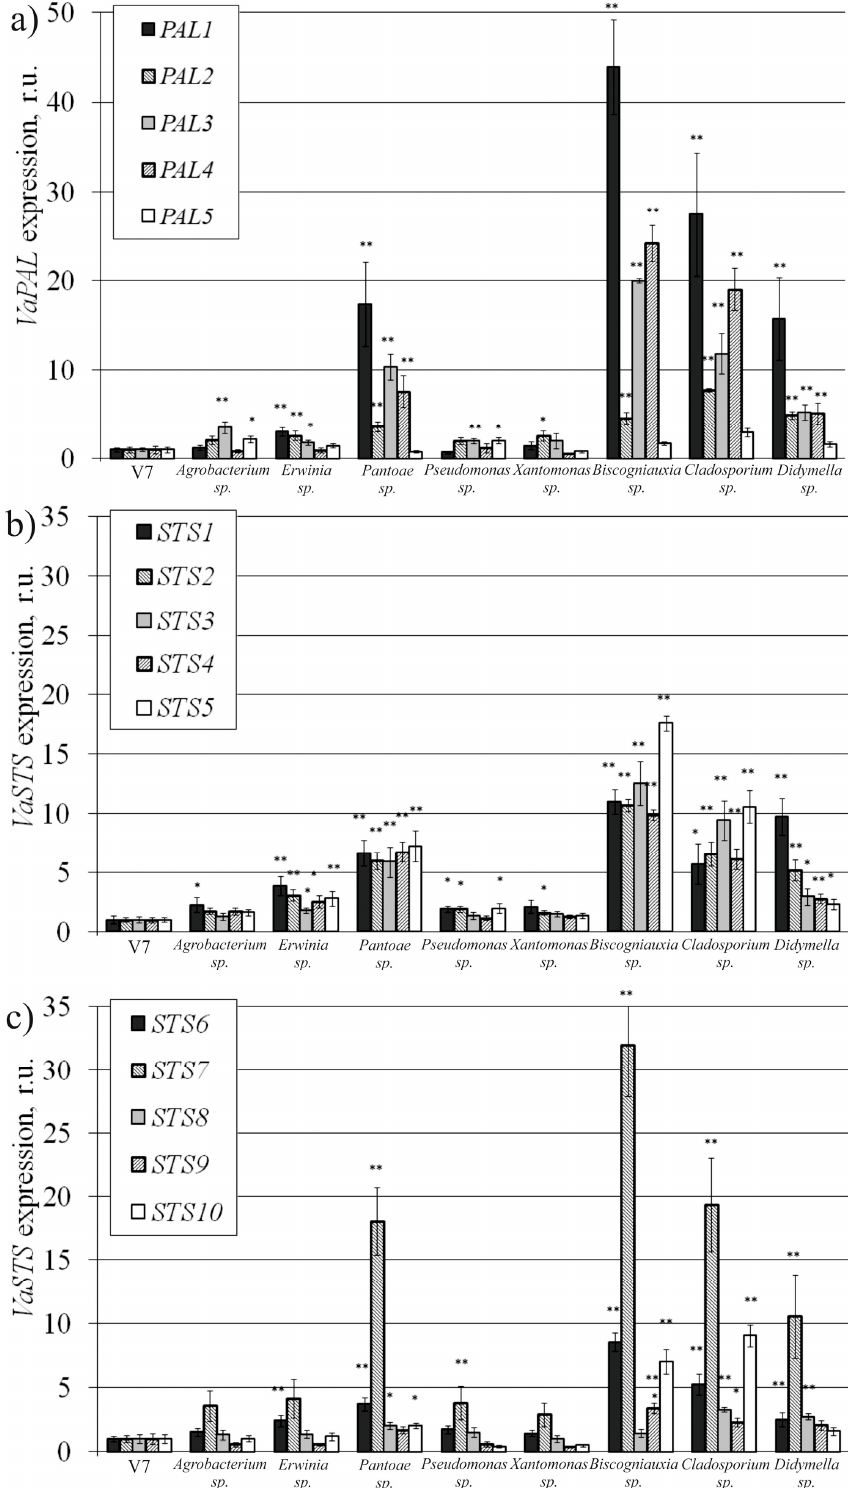
Figure 3. VaPAL ( a ) and VaSTS ( b , c ) gene expression in the V7 cell suspension culture of Vitis amurensis after 3 days of cocultivation with the endophytic bacteria Agrobacterium sp. , Erwinia sp. , Pantoae sp. , Pseudomonas sp. , Xantomonas sp. or fungi Biscogniauxia sp. , Cladosporium sp. , and Didymella sp. 2. * p < 0.05; ** p < 0.01 versus values of fresh biomass accumulation in the V7 cells cultivated under control conditions without bacteria and